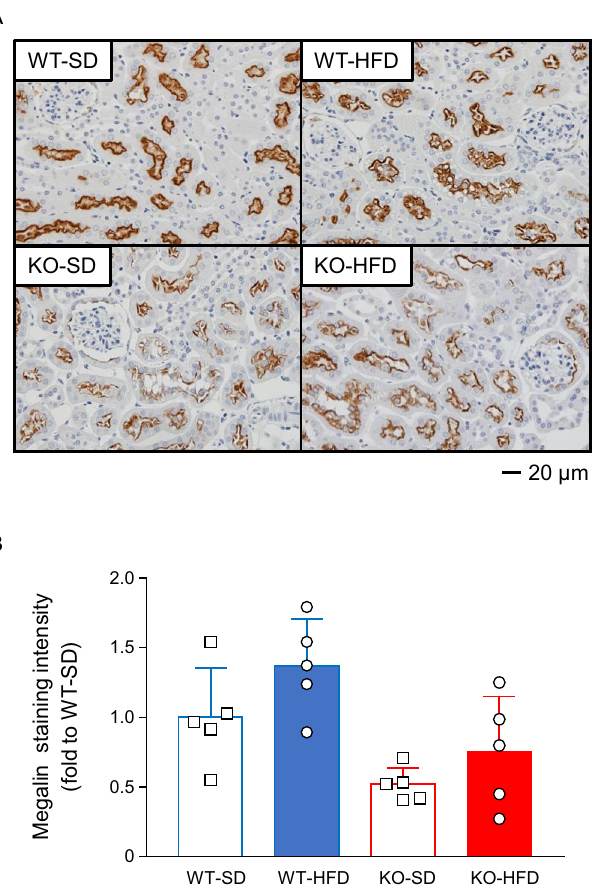
Figure 6. Protein expression levels of megalin in each group. ( A ) Immunohistochemistry for megalin (400 × , scale bar: 20 µm). Staining is primarily localized to the proximal tubules. ( B ) Staining intensity of megalin protein in the mouse kidney is presented as fold changes compared to the WT-SD group. Two-way ANOVA shows a significant main effect of only PGRN status on megalin protein expression. p < 0.01 for PGRN status; p = 0.64 for diet